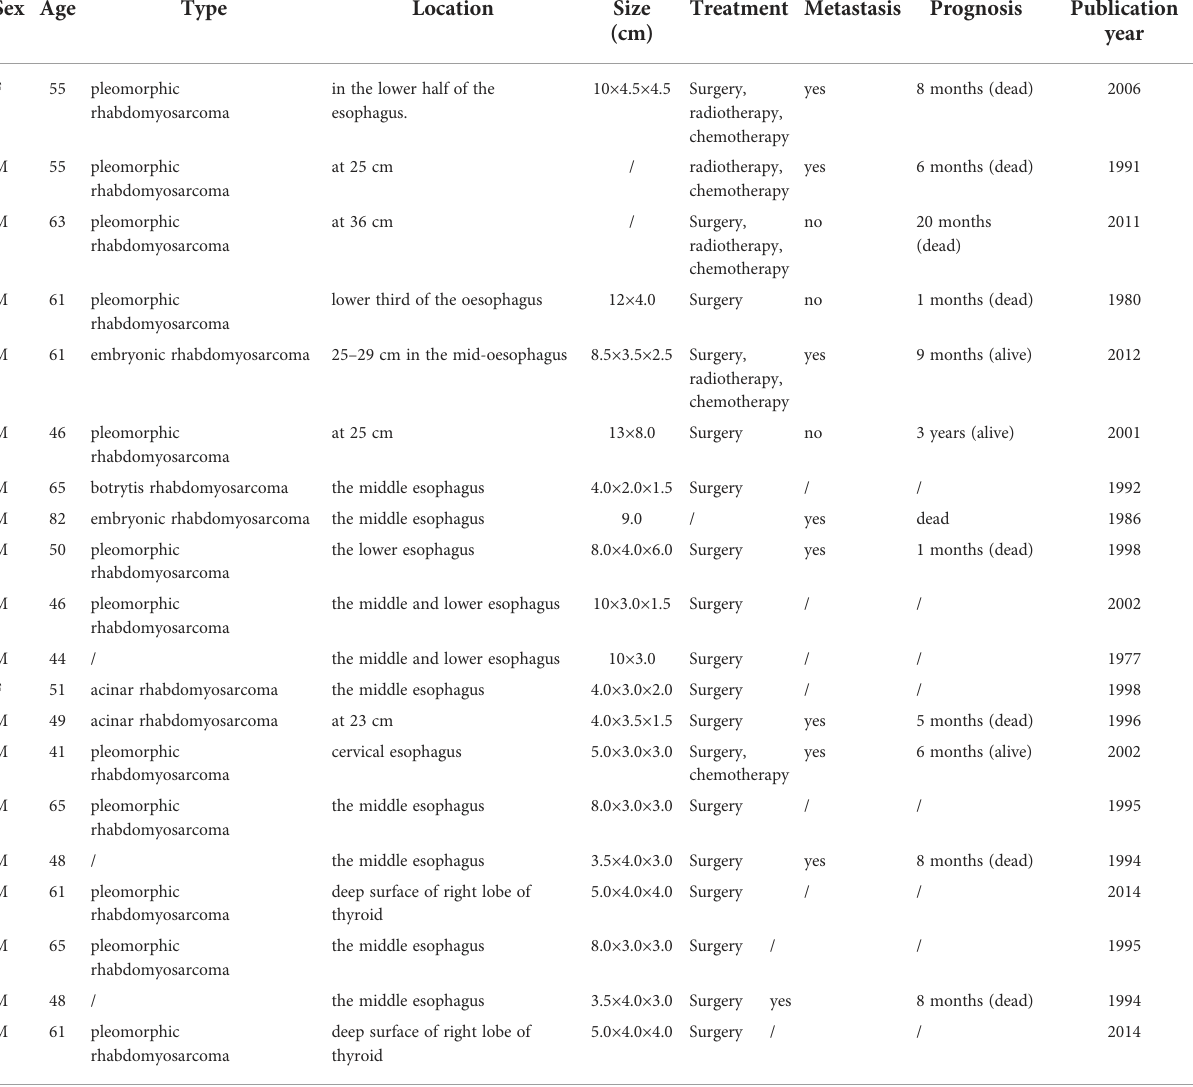
TABLE 1 Clinical features, treatments, and prognosis of the esophageal rhabdomyosarcoma. Sex